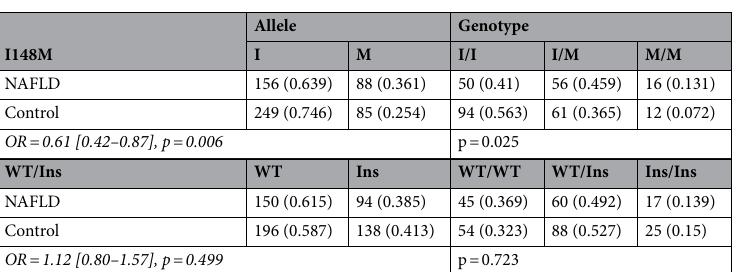
Table 1. Association of I148M and WT/Ins with NAFLD. Unlike I148M, the WT/Ins variant is not associated with NAFLD either in the allele or in the genotype analysis. Number of subjects/chromosomes are shown, frequencies are in brackets. Results are expressed as OR [5–95%].